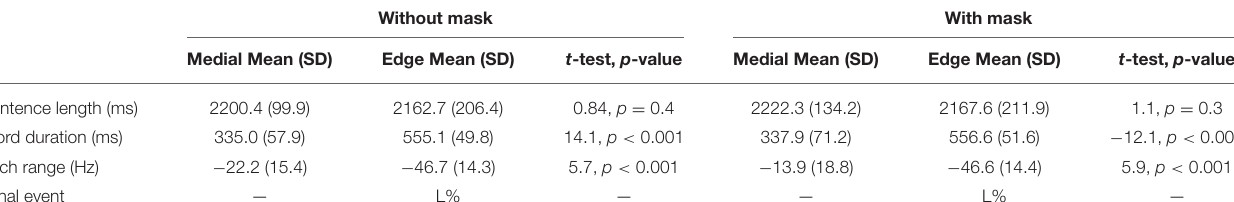
TABLE 1 | Acoustic properties of the auditory stimuli in the Auditory experiment across mask conditions.